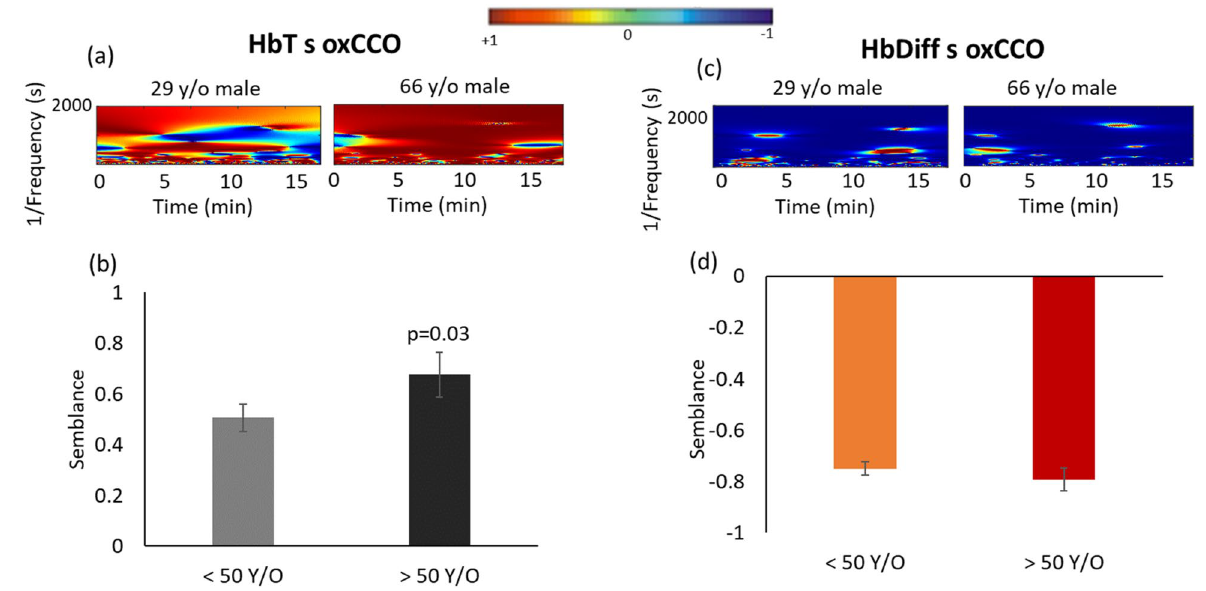
Figure 3. Semblance between mitochondrial oxidative metabolism (oxCCO) with total and difference hemoglobin signals (HbT and HbDiff markers for retinal blood volume and oxygenation, respectively) in dark. ( a ) HbT s oxCCO is greater in the 66-year-old (y/o) male compared to the 29 y/o male shown by predominantly red color representative of semblance + 1 ~ zero phase difference across all frequencies over time. ( b ) Group data for HbT s oxCCO averaged over all frequencies also showing significantly stronger semblance between total retinal blood volume with mitochondrial metabolism in subjects > 50 y/o (p = 0.03). ( c ) Showing a consistently antiphase relationship between HbDiff and oxCCO signals in dark in representatives 29 and 66 y/o male subjects (HbDiff s oxCCO predominantly blue across all frequencies, semblance −1 ~ 180° phase difference in both subjects). ( d ) Group data averaged across all frequencies showing no difference in HbDiff s oxCCO between < 50 and > 50 y/o, signifying a strong decoupling between retinal oxygenation and